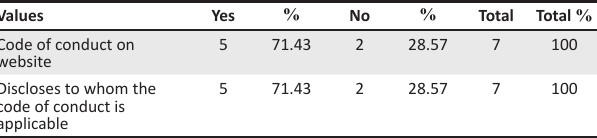
TABLE 3: Findings on the values principle.